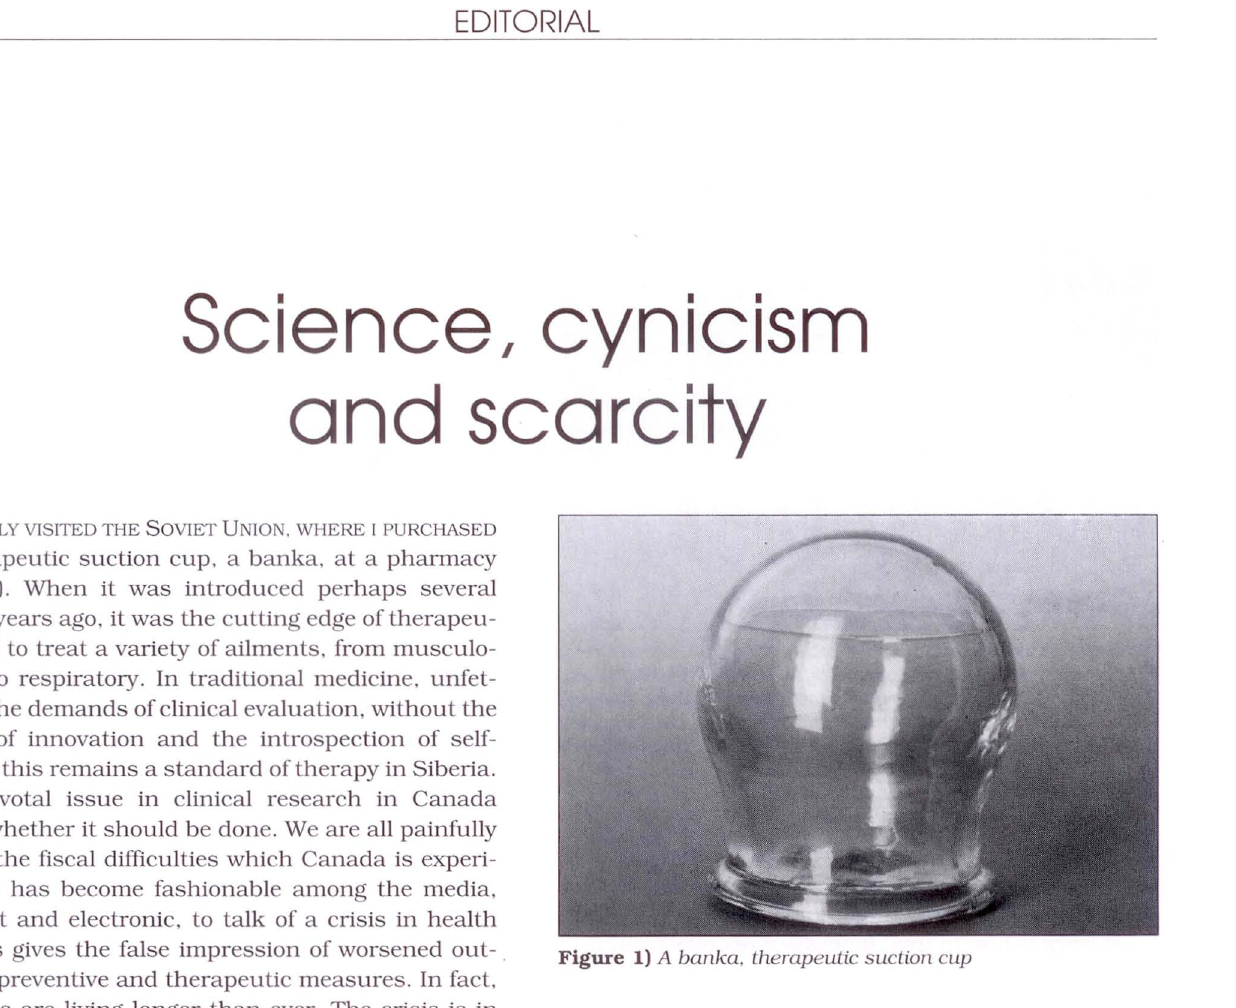
Figure 1) A ban/ca. therapeutic suction